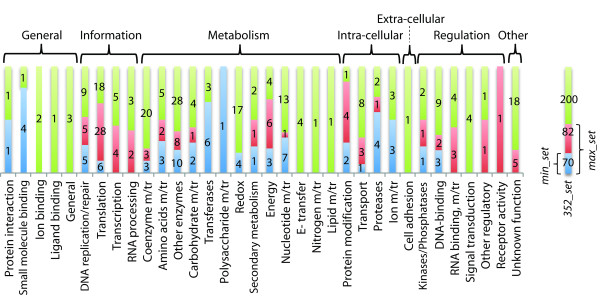
Distribution of molecular functions in the FSF 352_set that encompasses the urancestral max_set and min_set. In the diagram, the min_set has 70 FSFs. A total of 82 FSFs are unique to the max_set when compared to the min_set. The 200 remaining FSFs are not included in both of the urancestral sets. The bar graph displays 49 coarse-grained functional sub-categories (bottom labels) in seven major categories (top labels) defined by Vogel and Chothia [41]. Bars describe the number of FSFs in different sets, with heights normalized for sub-categories. The bars in the diagram show the initial appearance of molecular functions in the min_set or their additional accumulation in the max_set or 352_set for individual sub-categories. For example, the sub-category translation in Information has 6, 28, and 18 FSFs, that are included in the min_set, the 82 FSFs of the max_set, and the 200 FSFs of the 352_set, respectively. Here, 6 FSFs are common in all of the three sets, 28 FSFs are absent in the min_set but appear in the max_set and 352_set, and 18 FSFs are unique to the 352_set.